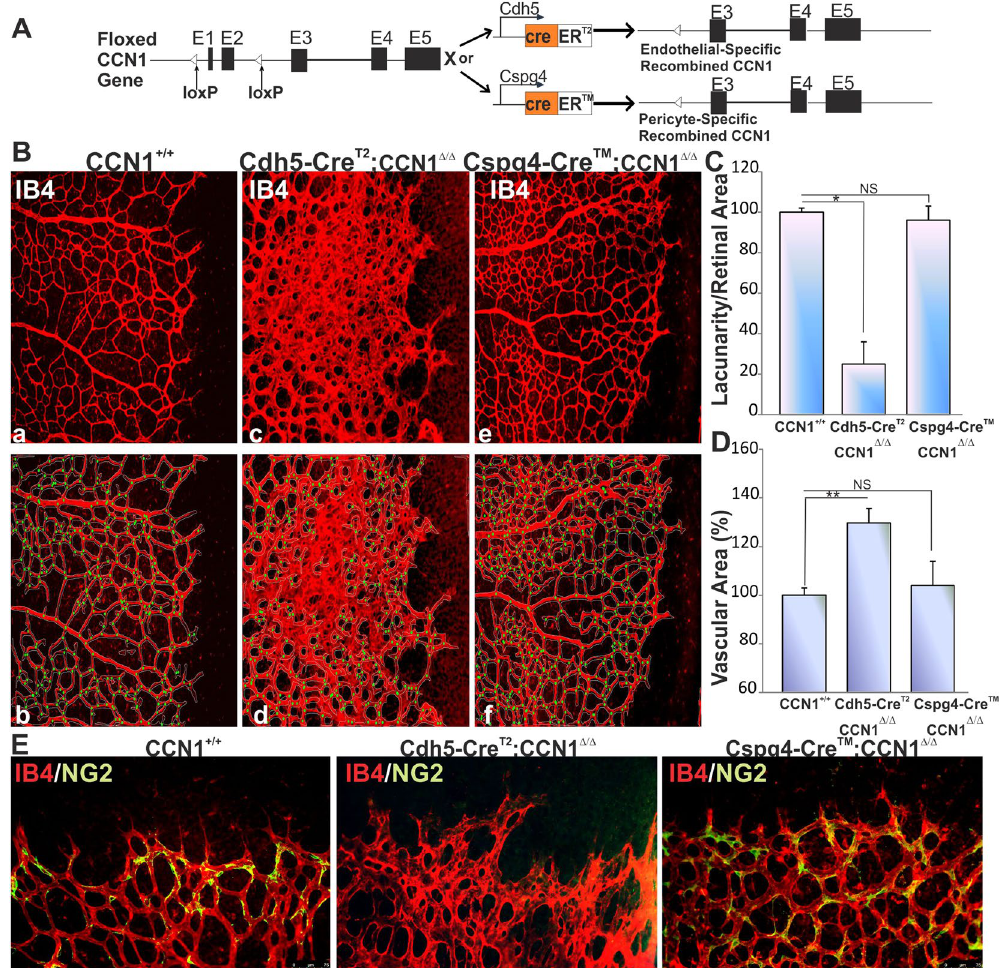
Figure 3. Effects of cell type-specific CCN1-deficiency on retinal vessel growth and development. ( A ) In the targeted CCN1 locus, exons 1 and 2 were flanked by loxP sites. Endothelial- or pericyte-specific promoter- mediated tamoxifen-induced cre excision removed the floxed fragment inactivating the CCN1 gene in the targeted cells. ( B ) Representative immunofluorescence images of IB4-stained whole retinal mounts of wild- type CCN1 + / + mice and their littermate with either endothelial- or pericyte-specific CCN1 deletion. Vascular parameters were analyzed using the AngioTool Software (b for a, d for c, f for e). The outline of the vasculature is shown in white. The vasculature skeleton representation is shown in red and branching points in green. ( C , D ) Quantitative analysis of vascular parameters of representative retinas of CCN1 + / + and CCN1 mutant mice. Graphical representations of the changes in vascular surface and lacunarity (i.e., the degree of “gappiness”) are shown. * p < 0.001 and ** p < 0.05 (n = 5). ( E ) Representative immunofluorescence images of dual IB4 (red) and NG2 (green) staining of whole mount retinas of wild-type CCN1 + / + mice and their littermate with either endothelial- or pericyte-specific CCN1